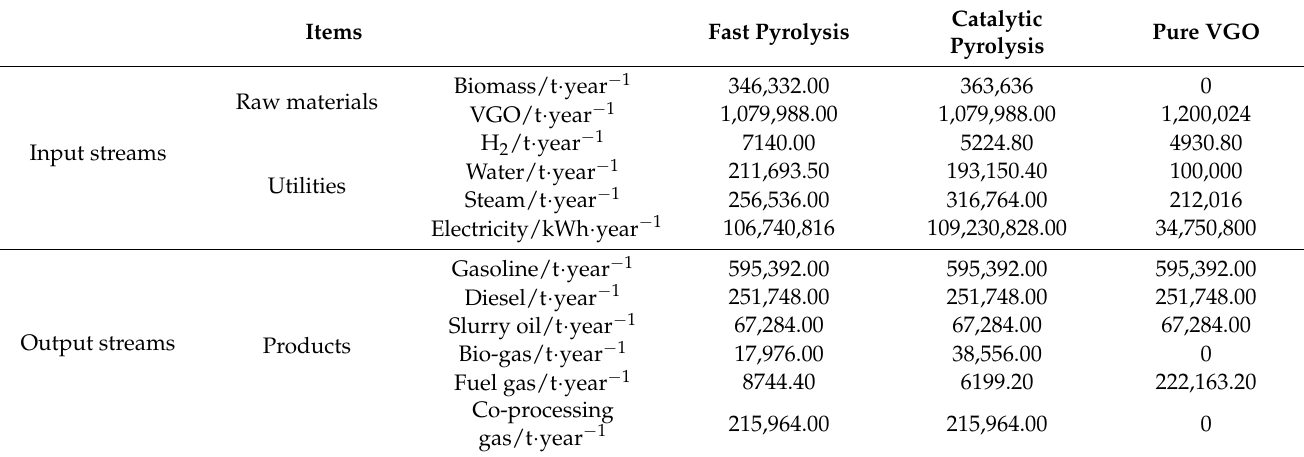
Table 8. Total consumptions of raw materials and utilities as well as products in Case 1.